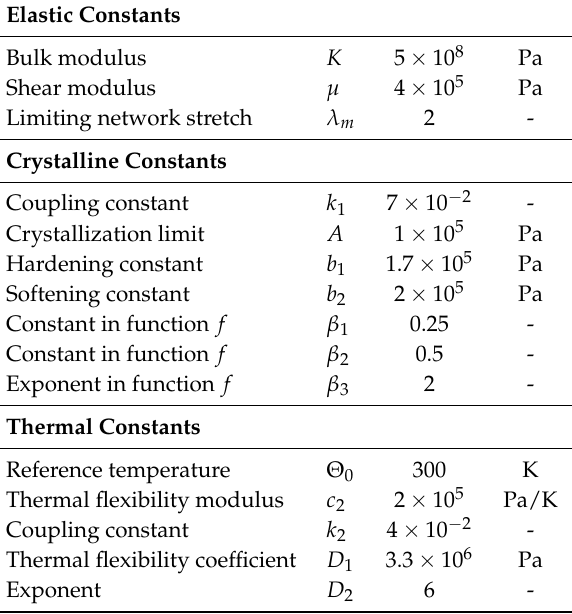
Table 1. Elastic, crystalline, and thermal material constants used in